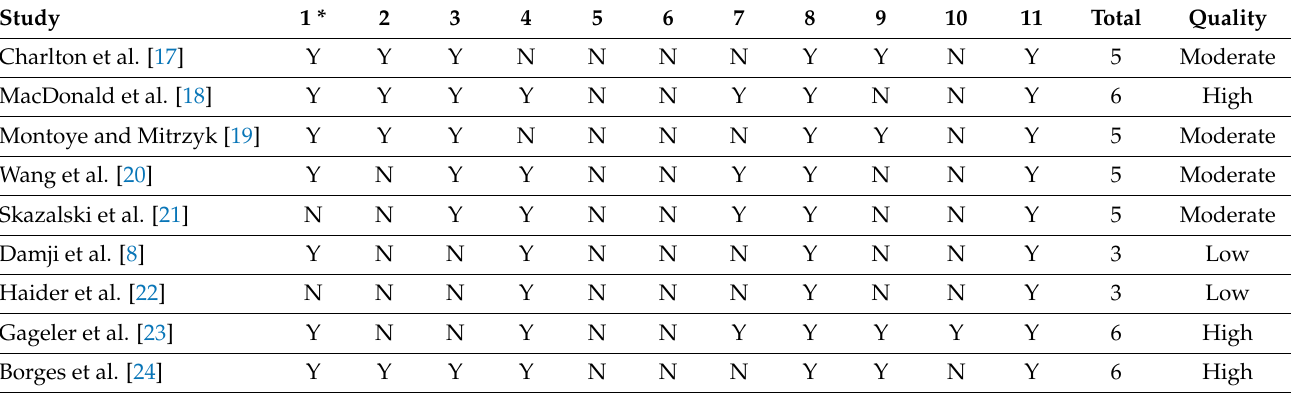
Table 1. Study quality based on the Physiotherapy Evidence Database (PEDro)